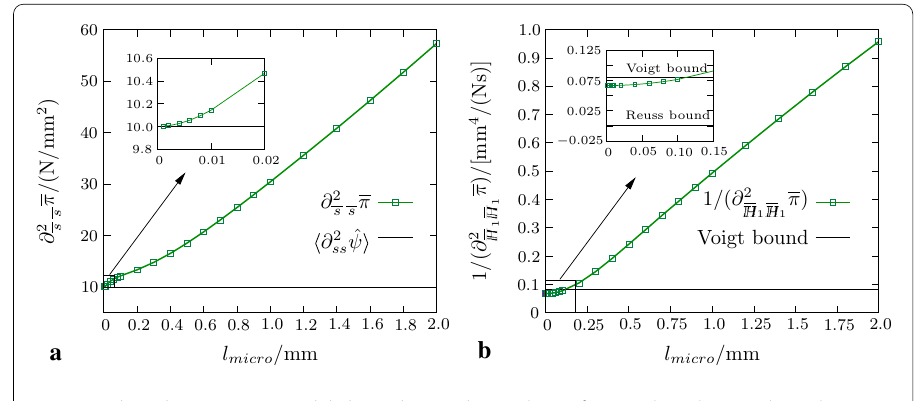
Fig. 10 Selected macroscopic moduli depending on the size l micro ofsquare-shapedRVEswithcircular inclusionswithvolumefraction f 0 = π/ 16. The chemical parameter of the matrix and the inclusions are chosen to A mat = A incl = 10N/mm 2 . The mobility parameters of the matrix and the inclusions are M mat = 0 . 1 mm 4 /(Ns) and M incl = 0 . 0001 mm 4 /(Ns) , respectively. a We observe that for vanishing size of the π converges to the homogeneous solution RVE l micro → 0, the macroscopic chemical parameter ∂ 2 (cid:6) ss ∂ (cid:15) ∂ 2 ˆ ψ (cid:16) = 1 ˆ ψ d V . b Furthermore, for vanishing size of the RVE, the macroscopic mobility parameter ss | B | B ss ∂ 2 π lies firmly within the Voigt and Reuss bound according to (42) HH